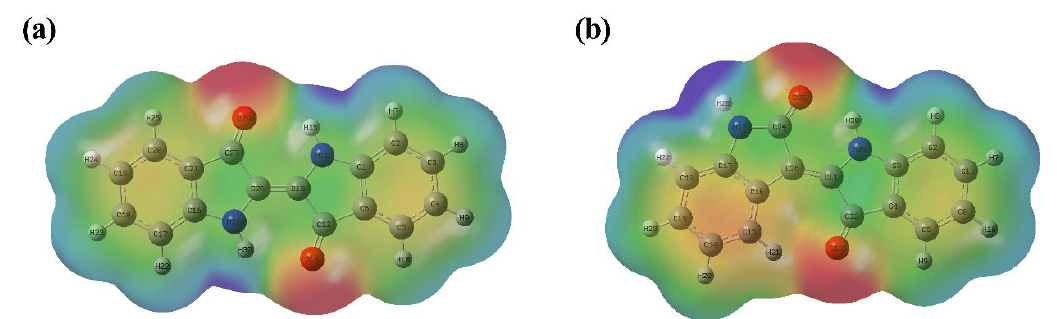
Figure 3. Total electron density mapped with electrostatic potential surface of indigo ( a ) and indirubin ( b ).